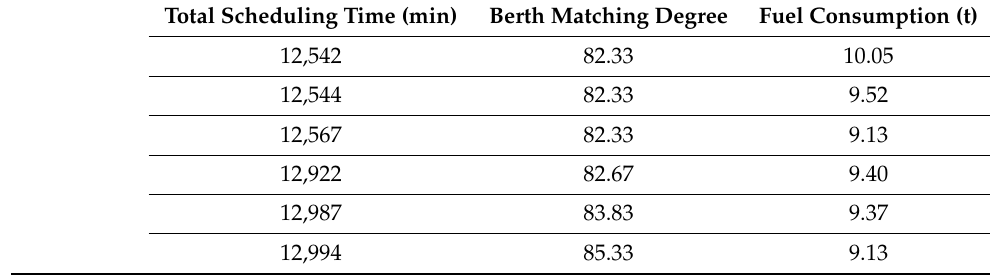
Table 6. Target values of solutions in the Pareto solution